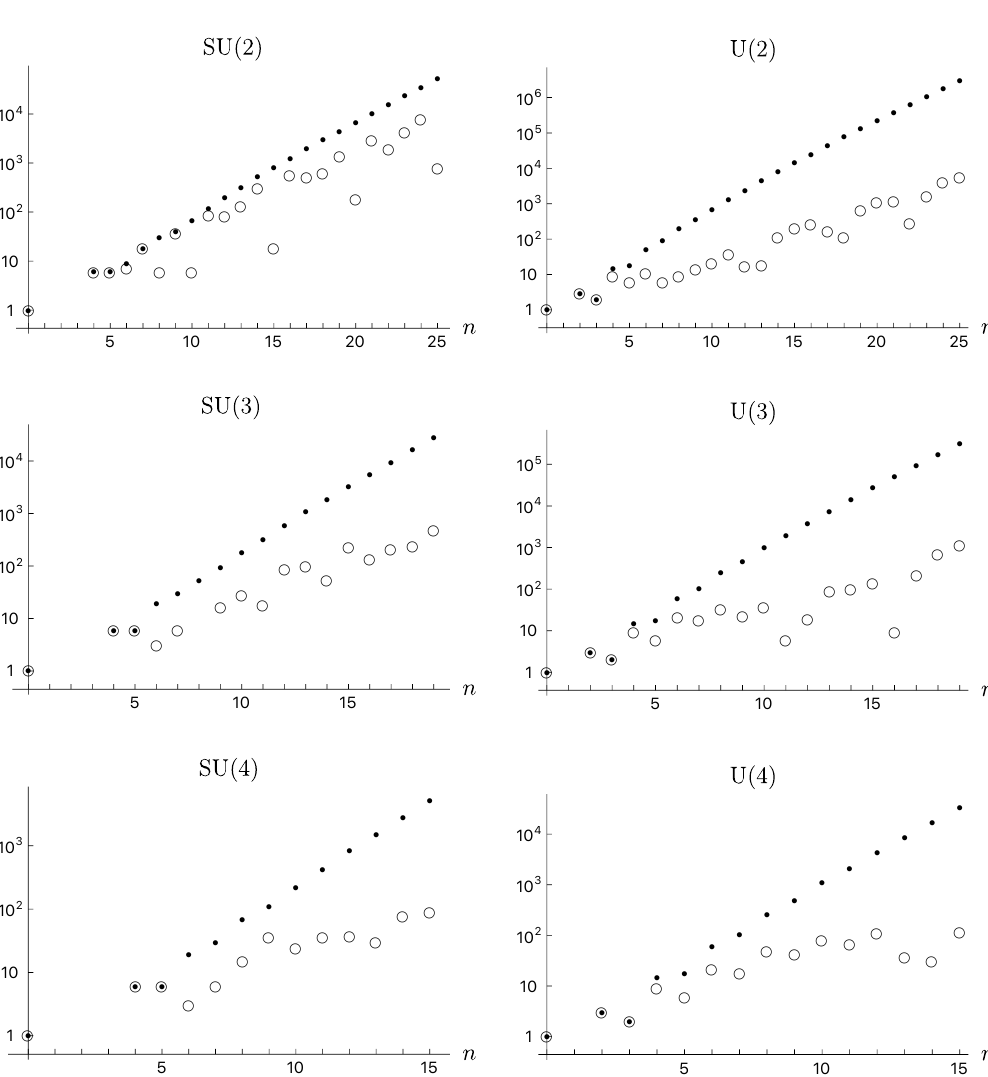
Figure 1 . Logarithmic plot of the number of 1/16-BPS states d N ( n ) (dots) and the absolute-valued index d N ( n ) (circles) at each n for SU( N ) and U( N ) gauge groups, N = 2 , 3 , 4